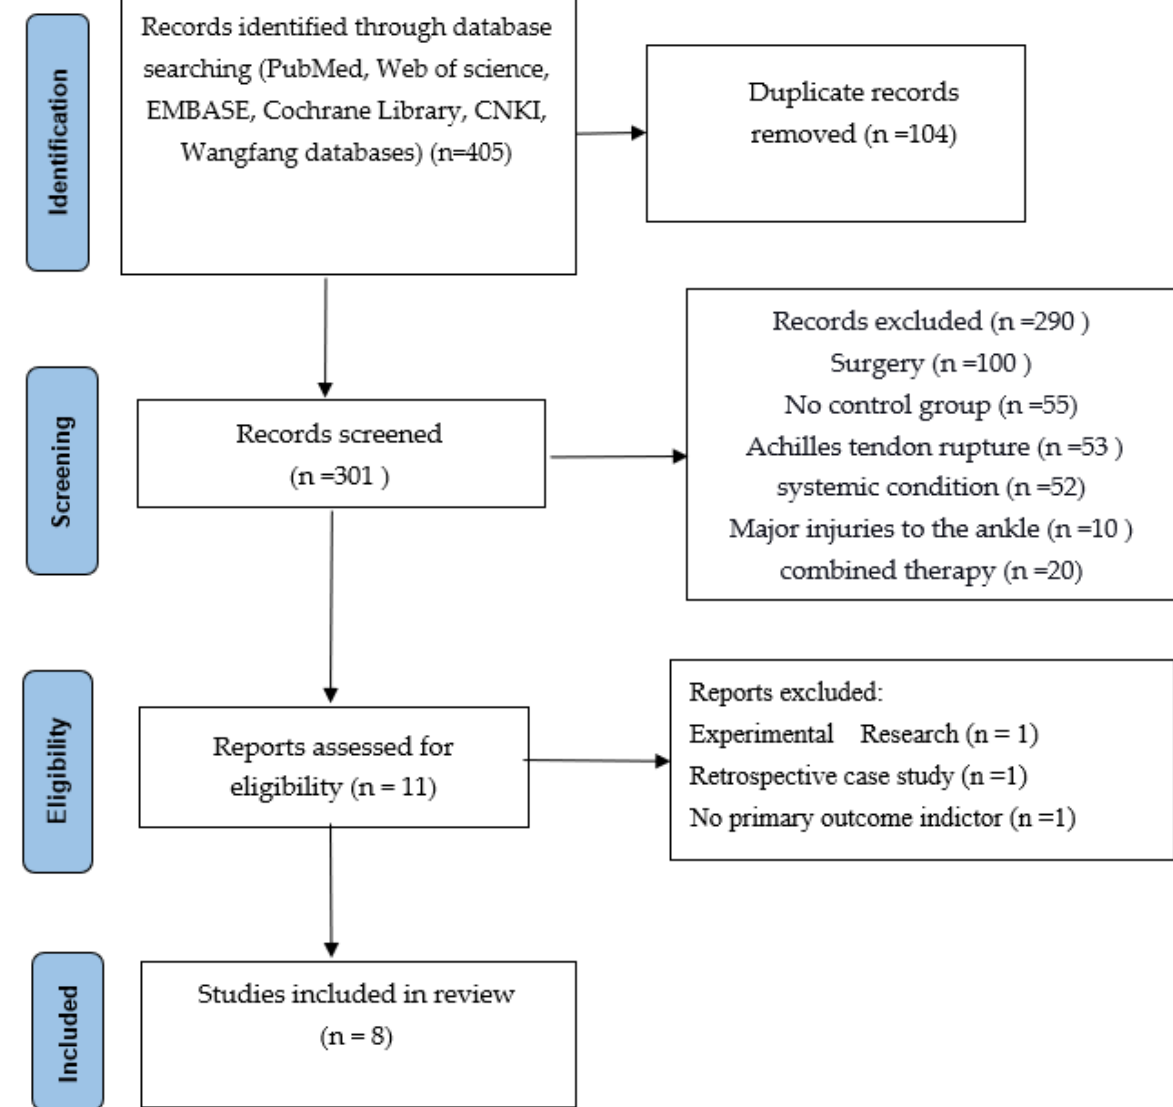
Figure 1. Literature screening flow chart.